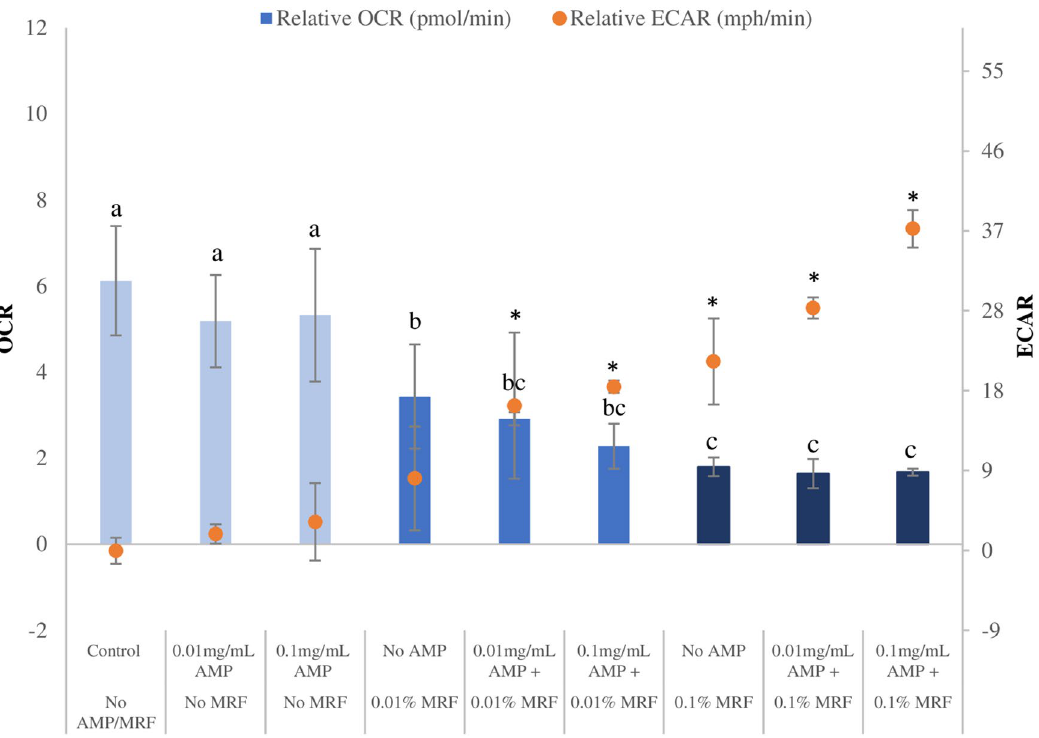
Figure 4. OCR (pmol) and ECAR (mph/min) end-point status following MRF and/or antibiotic treatment. End-point relative OCR (bars) and ECAR (data points) status of antibiotic resistant E. coli with and without MRF supplementation combined with and without ampicillin treatment. Each value was expressed using mean of triplicates for each biological replicate (n = 3), standard deviation is represented by error bars. OCR values that do not share a letter are significantly different ( p ≤ 0.05, ANOVA, Fisher-LSD). ECAR values marked with ‘*’ are significantly different to the control (no AMP/MRF) group ( p ≤ 0.05, ANOVA,